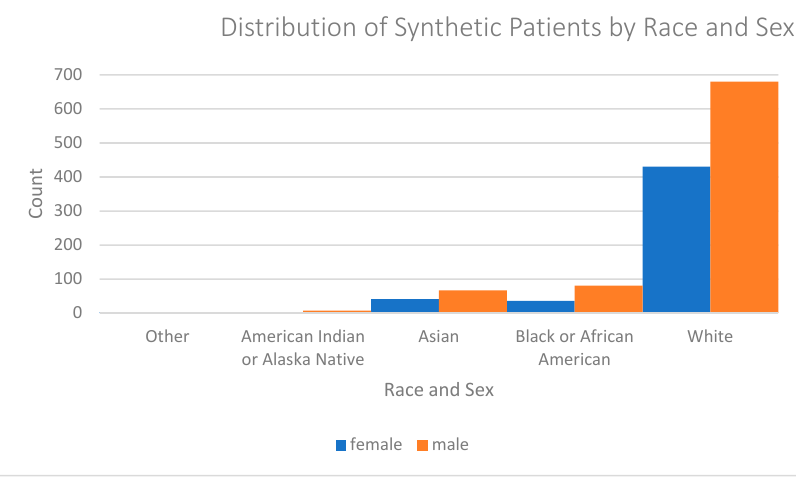
Figure A3. Distribution of patients by race and sex.